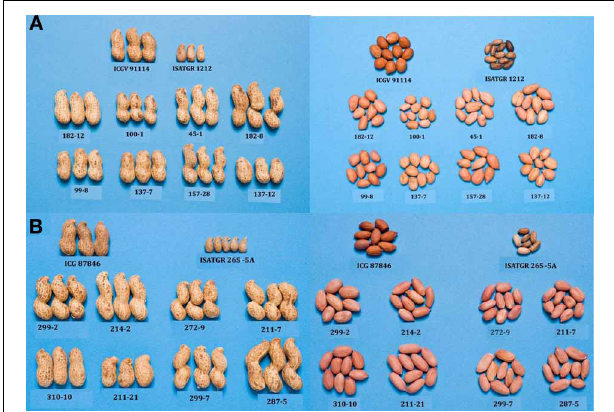
FIGURE 3 | Variability for pod and seed traits in AB-QTL populations derived from using synthetics in crosses between (A) ICGV 91114 × ISATGR 1212 (above) and (B) ICGV 87846 × ISATGR 265-5A